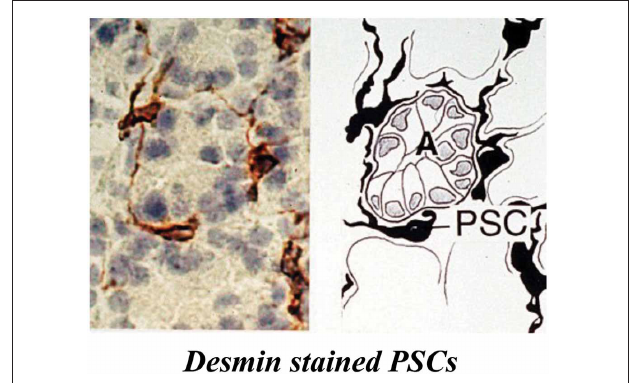
FIGURE 1 | Pancreatic stellate cells in rat pancreas stained for the selective marker desmin. The left panel shows a representative photomicrograph of normal rat pancreas immunostained for desmin. The right panel depicts the corresponding line diagram. Desmin positive PSCs with long cytoplasmic projections are located at the basolateral aspect of acinar cells (A). Reprinted with permission from BMJ Group .